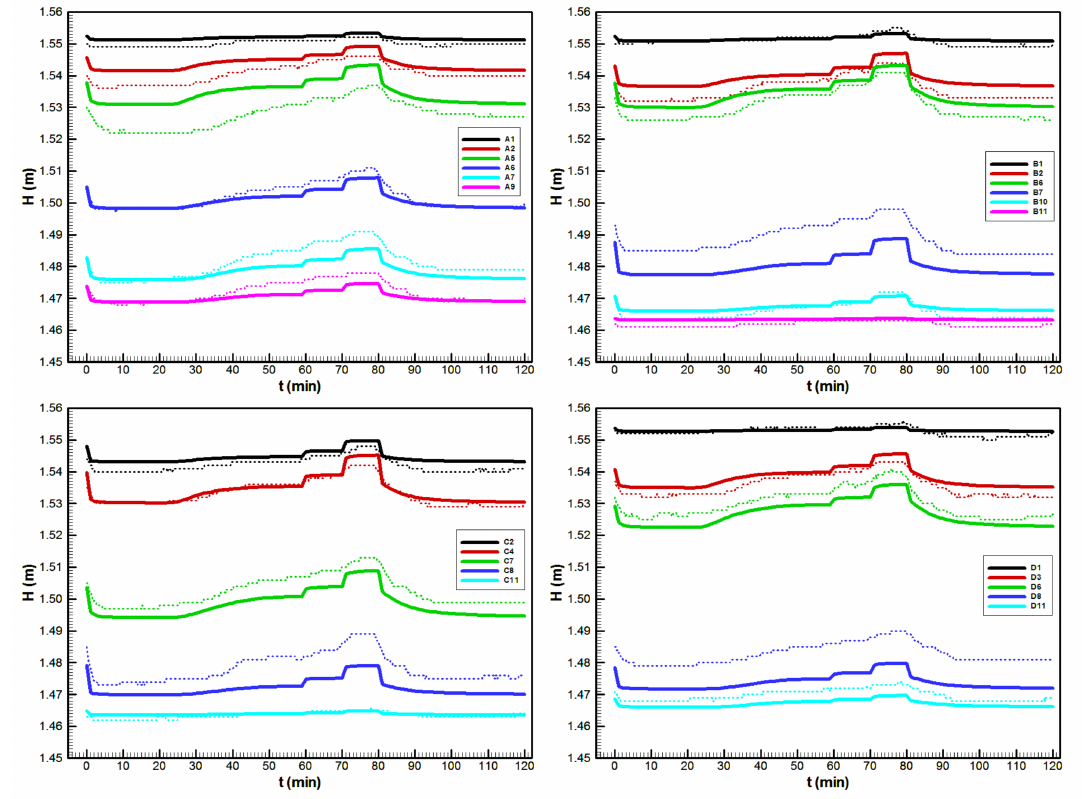
Figure 10. Hydraulic head: Experimental (dashed line) and numerical (solid line)